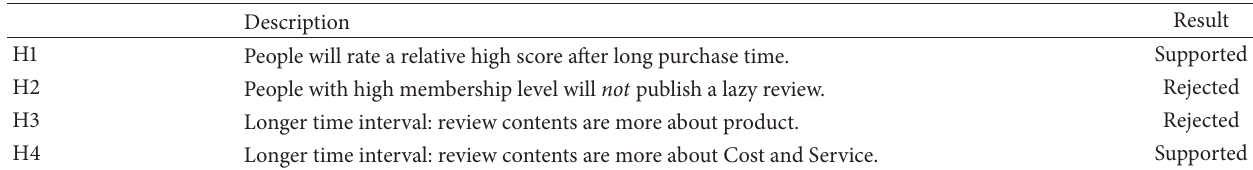
Table 9: Summary of